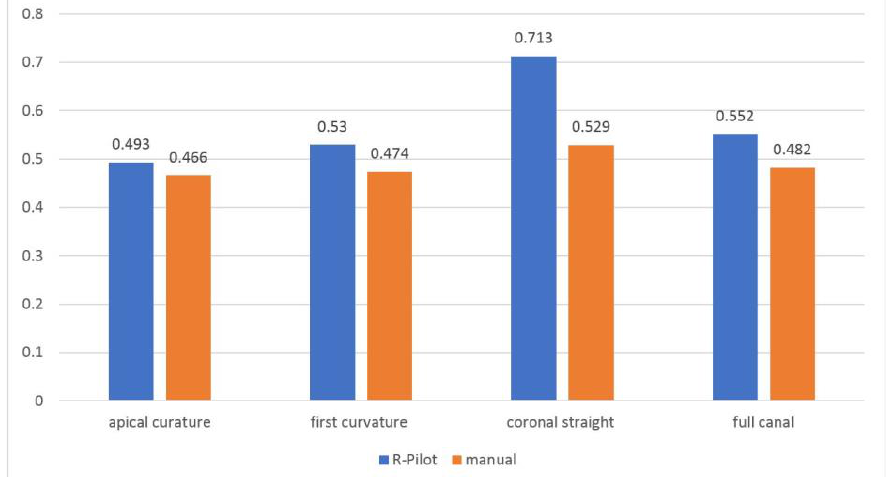
Figure 2: Average value for canal centric after creating the glide path using different